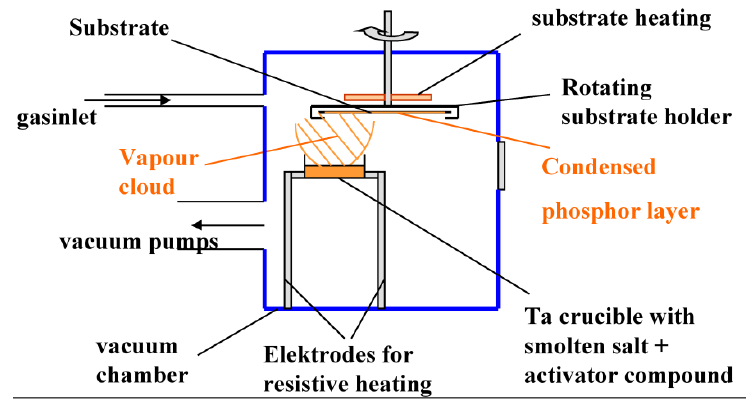
Figure 19. Schematic drawing of a thermal vapor deposition unit for NIP manufacturing.